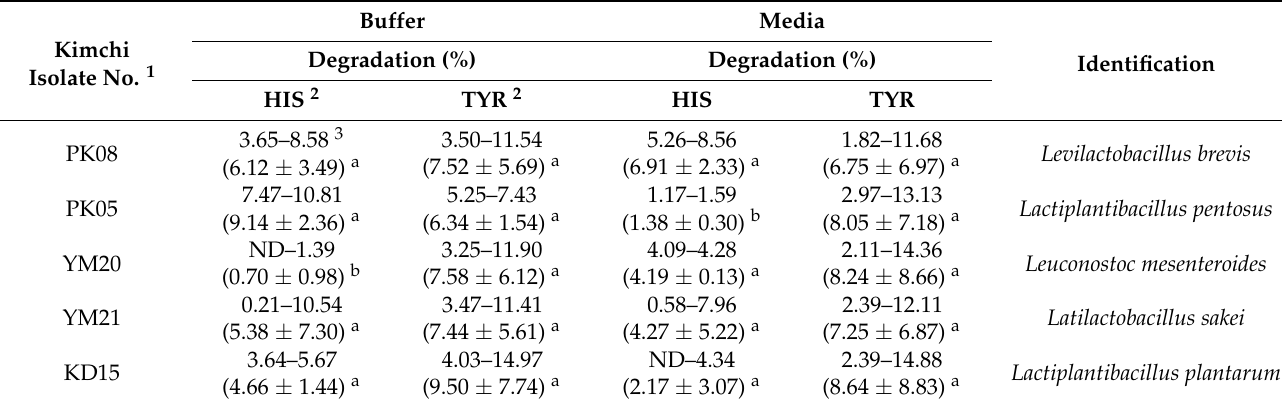
Table 1. Degradation rates of histamine and tyramine in buffer and media by selected LAB strains originated from kimchi